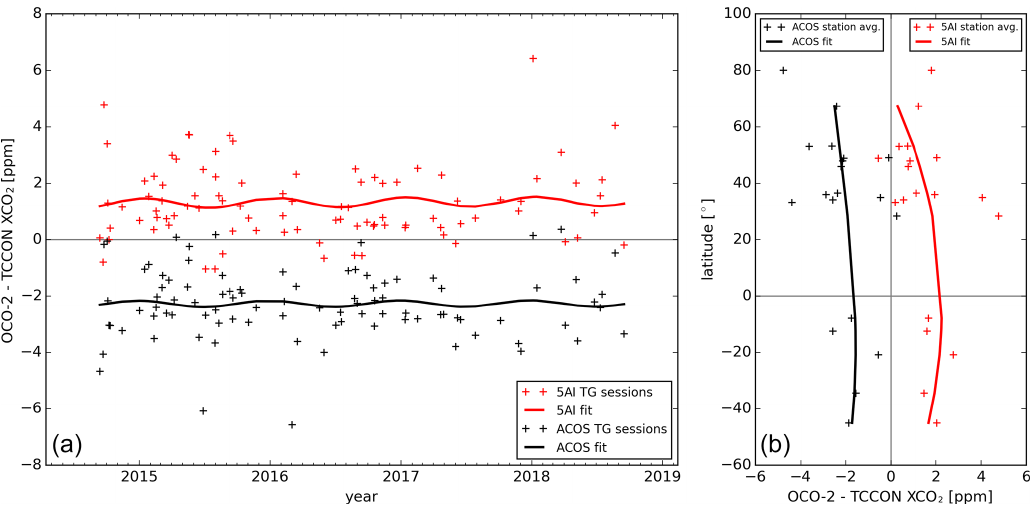
Figure 4. The 5AI and raw ACOS B8r OCO-2 target X CO bias compared to TCCON as a function of time (a) and latitude (b) . Crosses 2 show the individual session averages in panel (a) and individual station averages in panel (b) . The full lines show the polynomial fits of this bias for all target sessions.